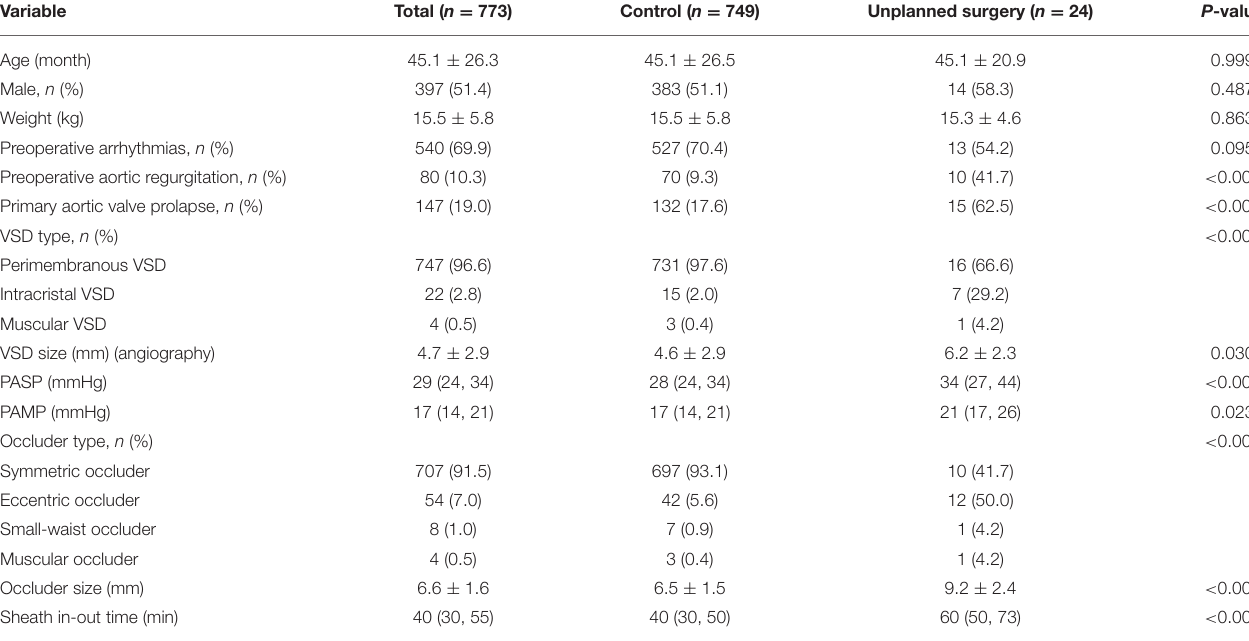
TABLE 1 | General characteristics.